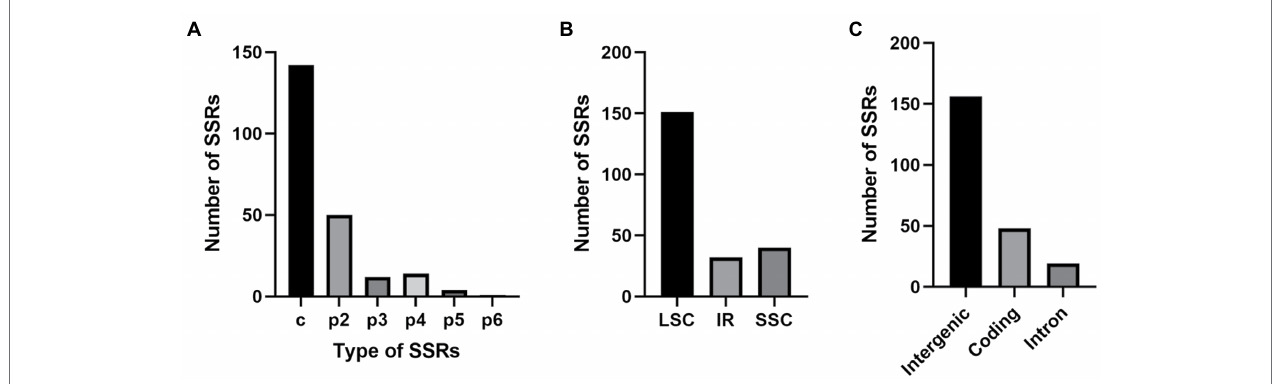
FIGURE 3 | The type, distribution, and presence of simple sequence repeats (SSRs) in E. breviscapus cp genome. (A) Number of different SSR types detected in E. breviscapus cp genome. (B) Frequency of SSRs in the large single copy (LSC), small single copy (SSC), and inverted repeat (IR) regions. (C) Frequency of SSRs in the protein-coding regions, intergenic spacers, and intron.